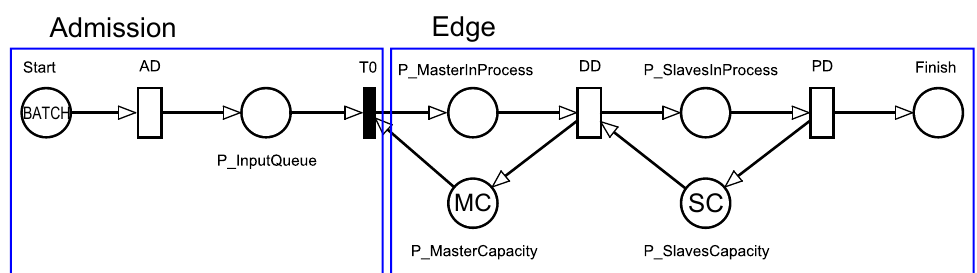
Figure 8. SPN Model Using Absorbing State.